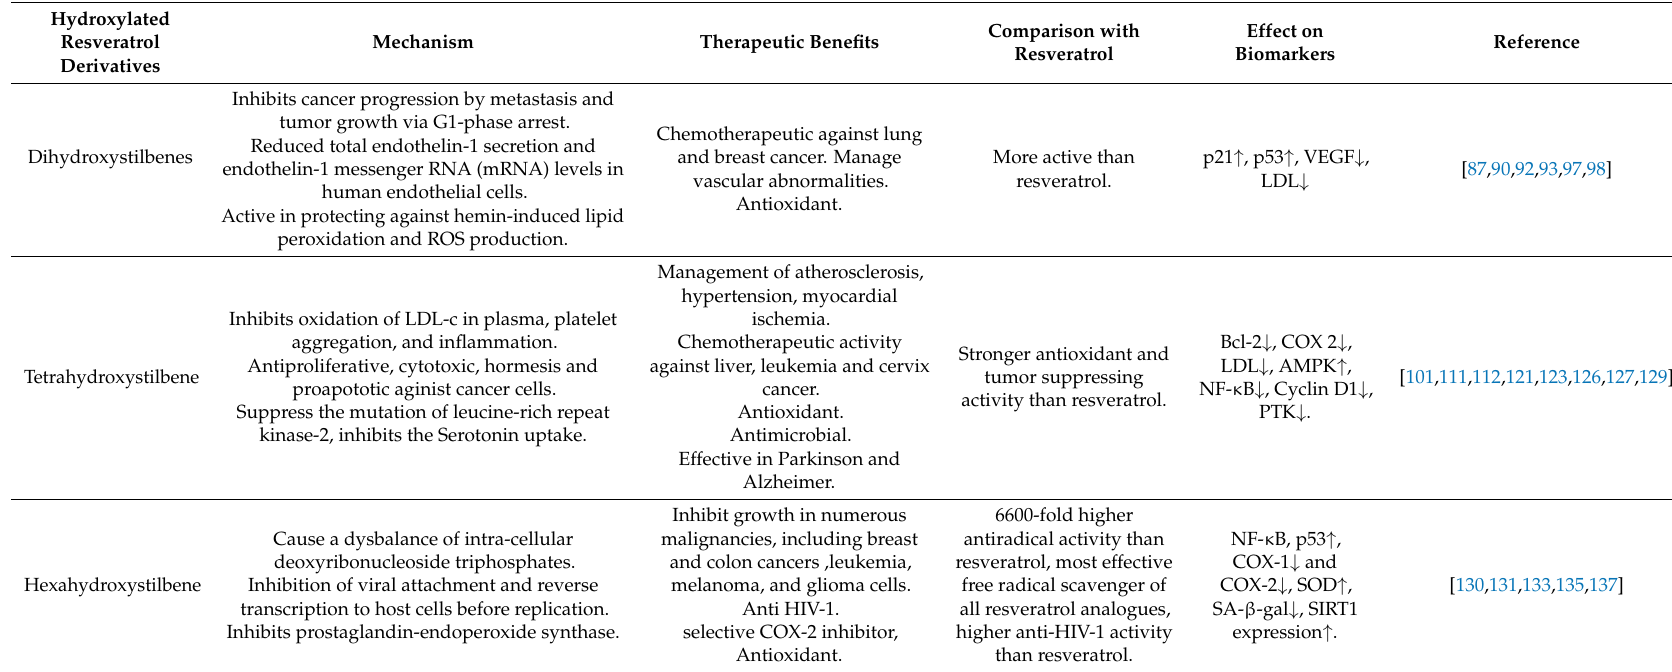
Table 2. Overview of hydroxylated resveratrol derivatives, there therapeutic benefits, mechanism and effect on various